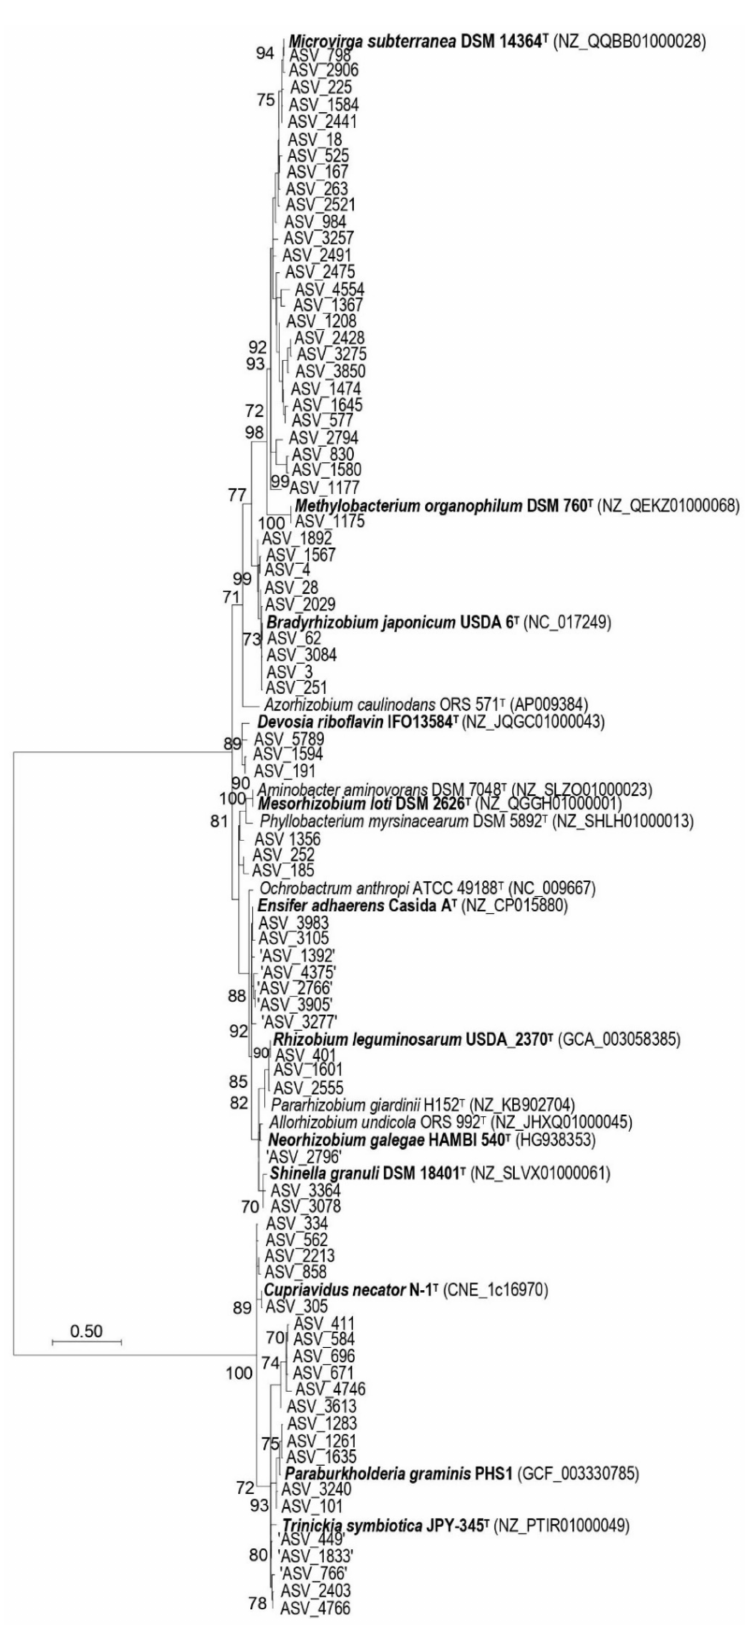
Figure 2. An unrooted phylogenetic tree of ASVs of rhizobia detected in savannah soils of Northern C ô te d’Ivoire using the 16S rDNA V4-V5 variable region with all the type species of 18 Alpha -